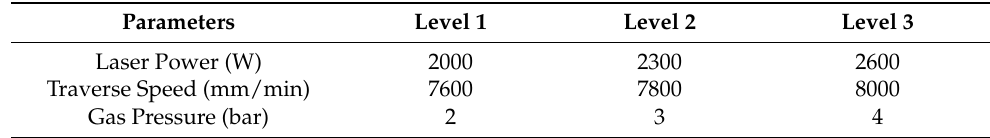
Table 3. Input parameters values for specimen thickness of 6 mm. FTC: 2000 W laser power, 8120 mm/min traverse speed, and 2 bar gas pressure.